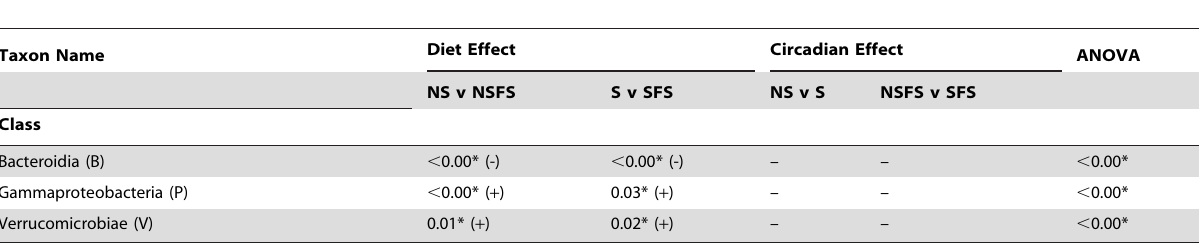
Table 2. Significant between group comparisons by taxon